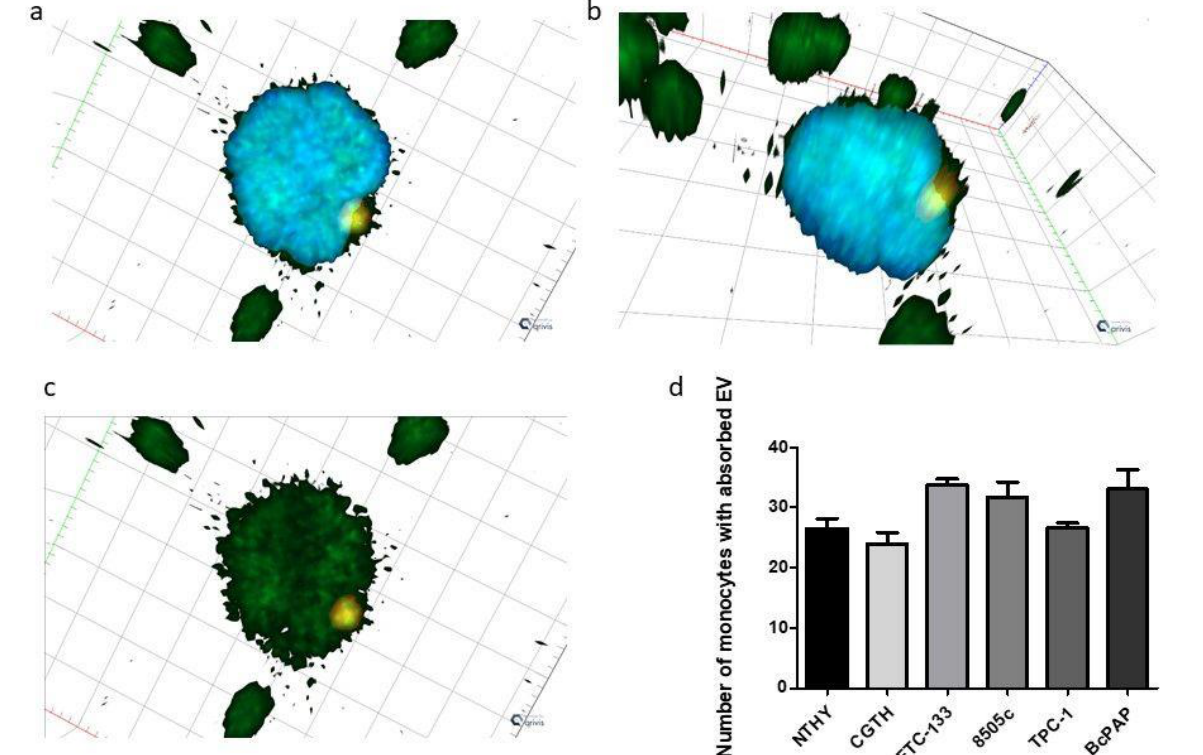
Figure 8. Internalization of thyroid cancer-derived extracellular vesicles (EVs) by monocytes. ( a – c ): a 3D model of internalized EVs visualized by confocal microscopy (Zen software—ZEISS). Actin has been stained with Phalloidin-FITC (green), EV Caveoiln-1 with AF 594 (red), and nucleic DNA with DAPI (blue). ( a , b ): a monocyte with internalized EV in two different positions; ( c ): a monocyte with internalized EV without a channel for nucleus. ( d ): numbers of monocytes with absorbed EVs, released by different thyroid cell lines.